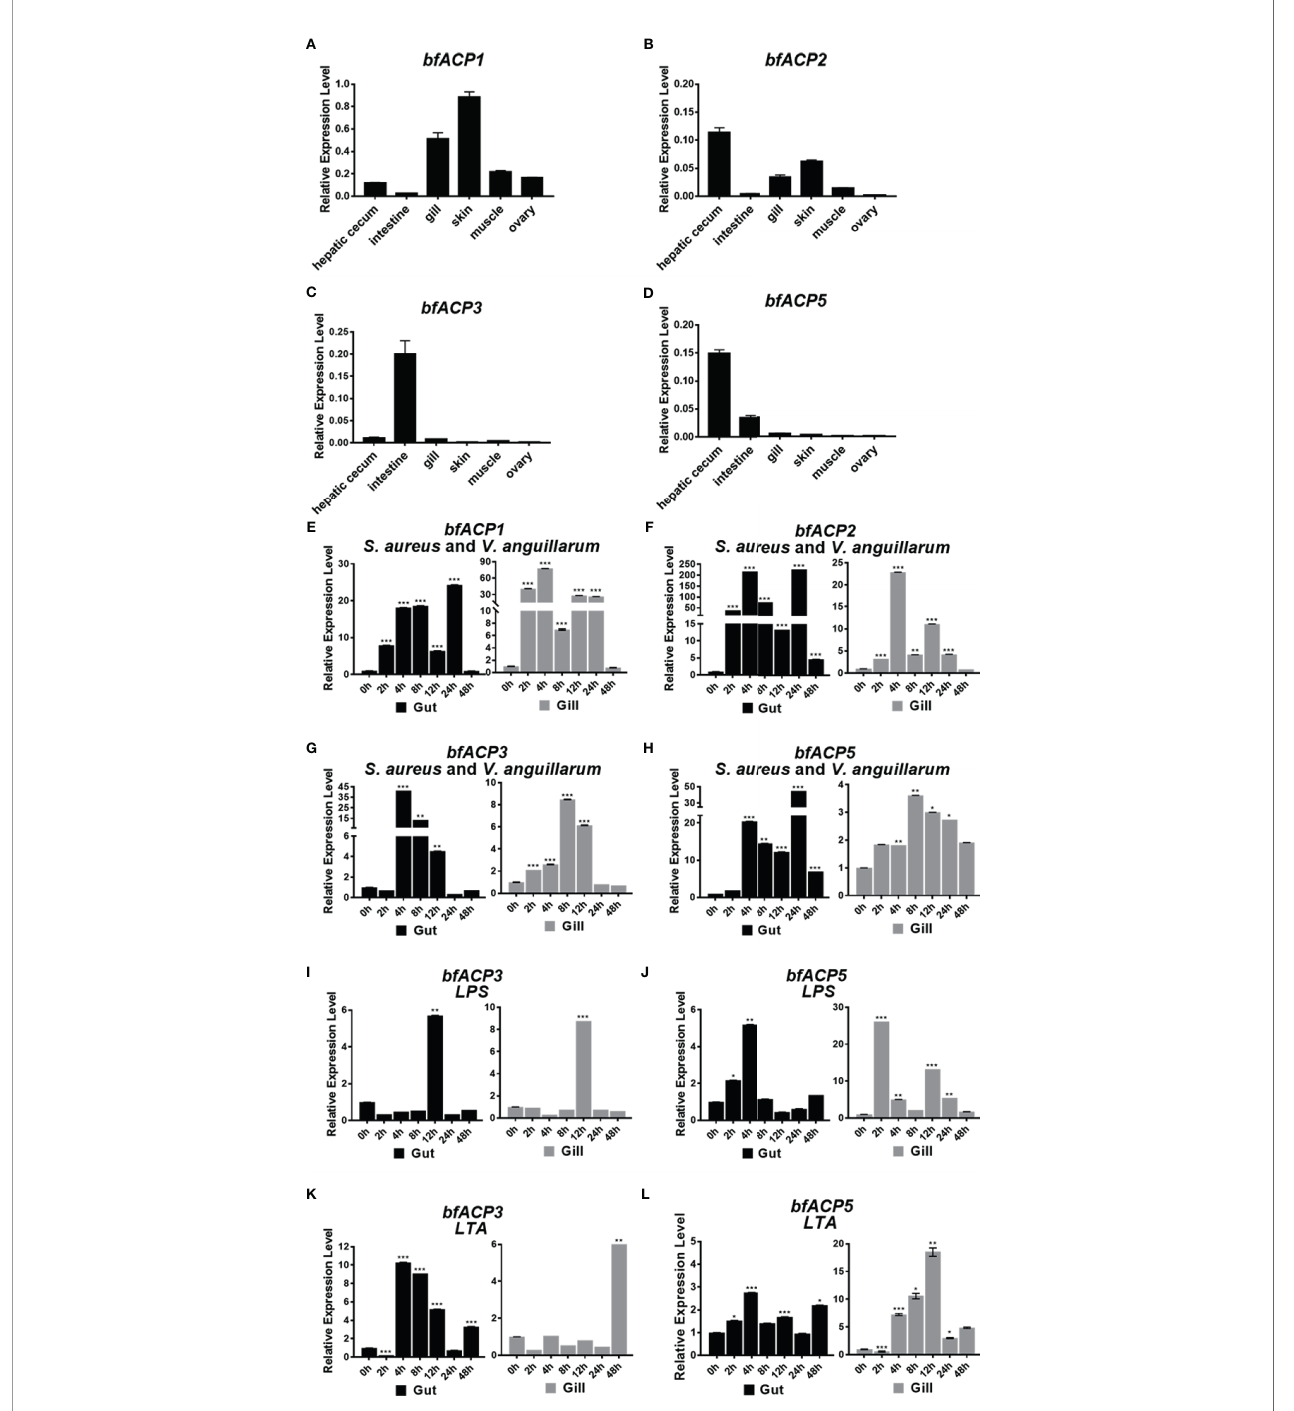
FIGURE 2 | Q-PCR analysis of the expression pro fi le of bfACP3 and bfACP5 . The relative level of bfACP1 (A) , bfACP2 (B) , bfACP3 (C) and bfACP5 (D) mRNA in different tissues, respectively. Experiments were performed with fi ve amphioxus. Data were expressed as a ratio to the gapdh mRNA expression and were plotted as the mean ± SD. (E – H) The relative expression level of ACP mRNA in gut (hepatic cecum and intestine) and gill after challenge with mixed inactivated bacteria ( S. aureus and V. anguillarum in 1:1 ratio). (I – L) The relative expression level of bfACP3 and bfACP5 mRNA in gut (hepatic cecum and intestine) and gill after challenge with Gram-negative cell wall component LPS (1mg/mL) and Gram-positive bacteria cell wall component LTA (1mg/mL) for different time. Data were expressed as a ratio to the ACP mRNA expression level of unchallenged naive animals and were normalized to the gapdh expression. All the samples were analyzed in three replicates and mean ± SD is plotted, * p < 0.05, ** p < 0.01, *** p < 0.001. One representative experiment out of three is